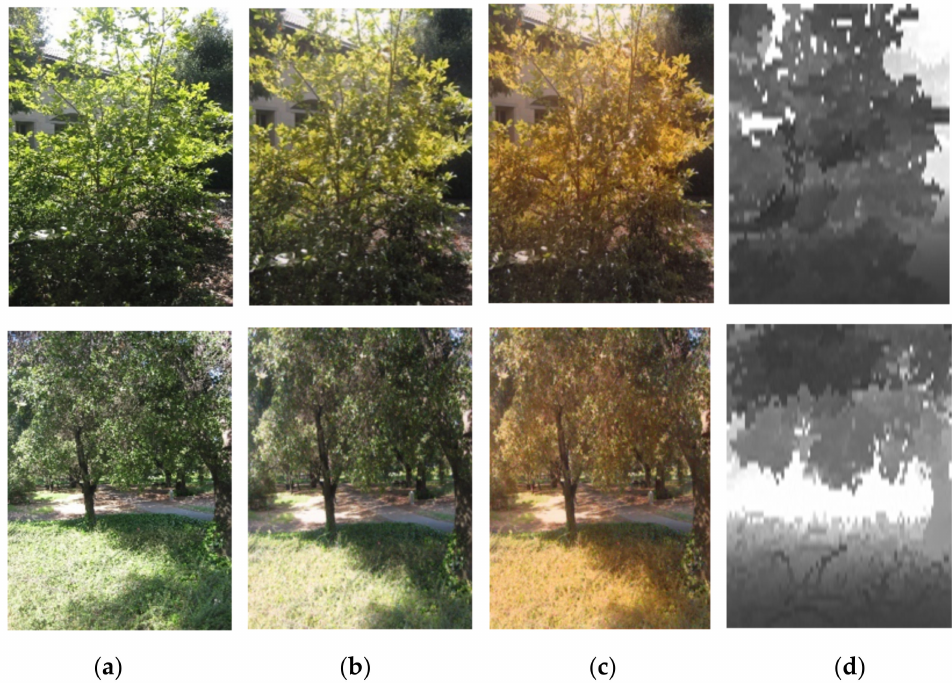
Figure 4. Synthetic-image display. ( a ) Original image; ( b ) synthesized image; ( c ) synthesized image; ( d ) depth